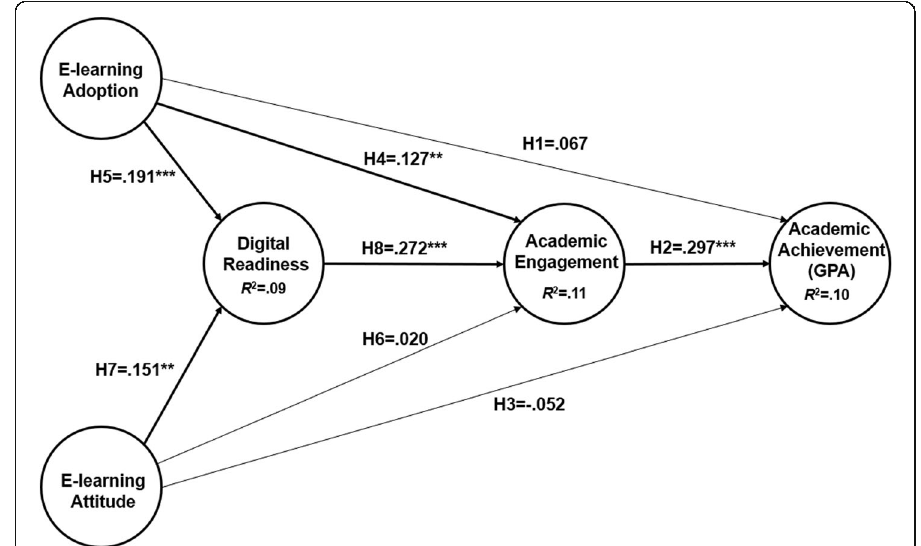
Fig. 2 PLS model of attitude toward e-learning and academic